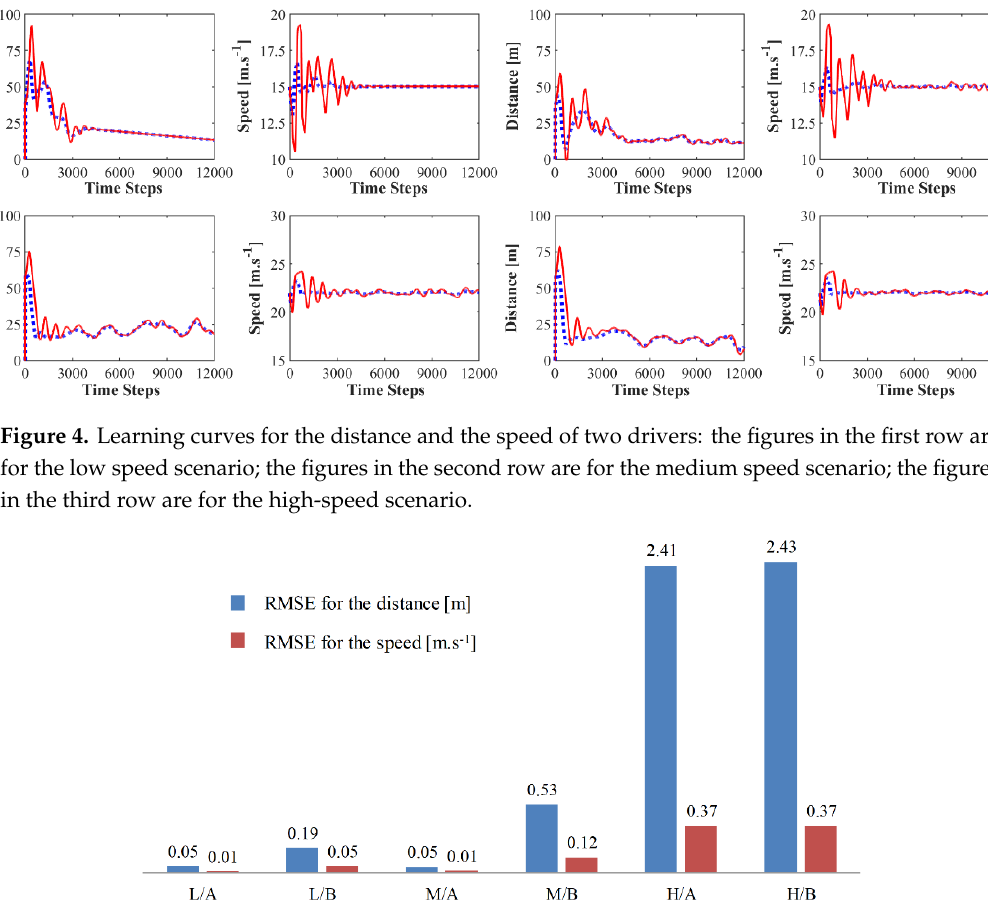
Figure 5. Root Mean Square Error (RMSE) for the constant speed scenarios.